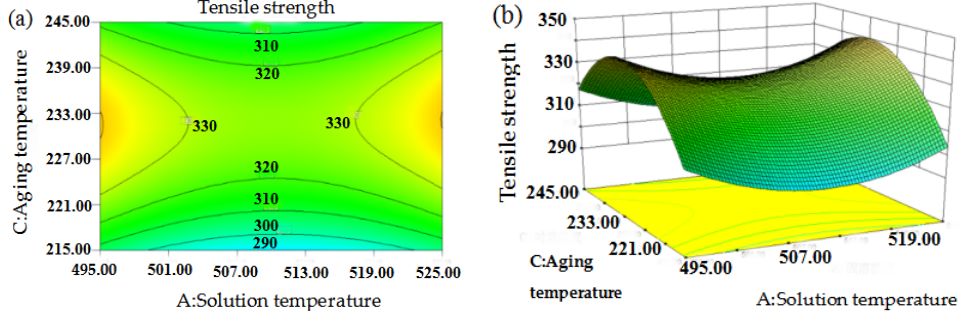
Figure 12. Interaction between ageing temperature and solution temperature versus the tensile strength. ( a ) contour map; ( b ) surface response map.